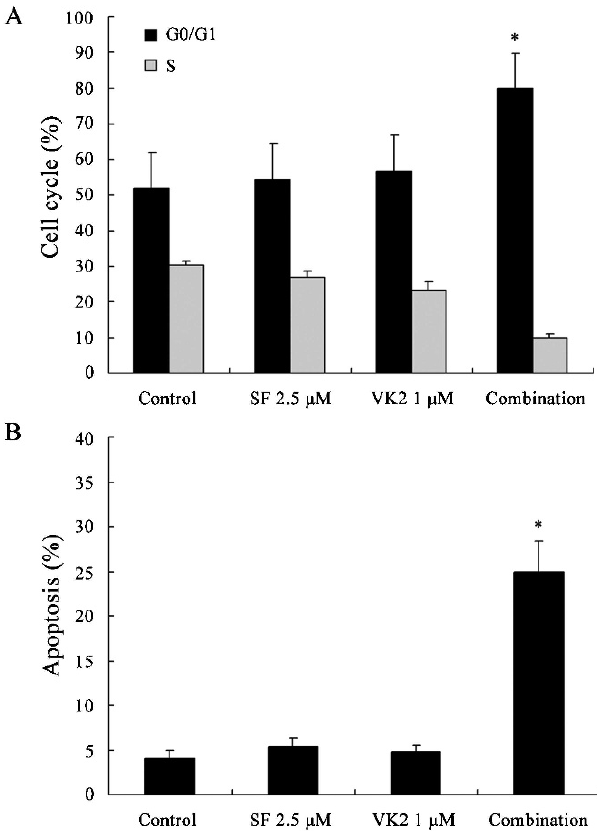
Figure 2 - Induction of cell cycle arrest and apoptosis by the combination of sorafenib and VK2. (A) Percentages of cell cycle distribution. (B) Percentages of apoptotic cells. Values represent the mean ¡ SD of five independent experiments. * p , 0.05 vs. control or single-agent treatment.